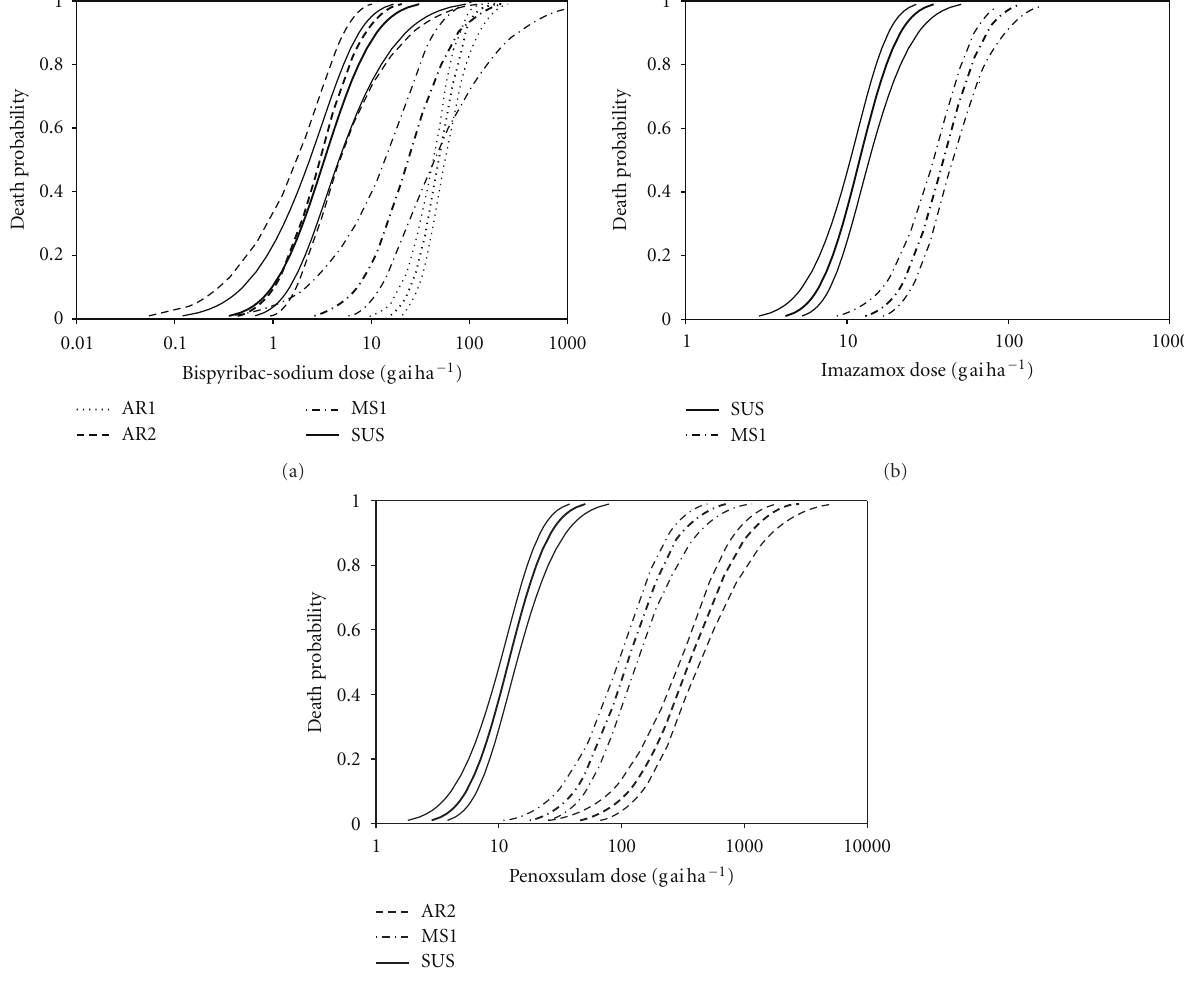
respectively. The resistance index based on LD 50 values revealed that AR1 and MS1 populations were 15 and